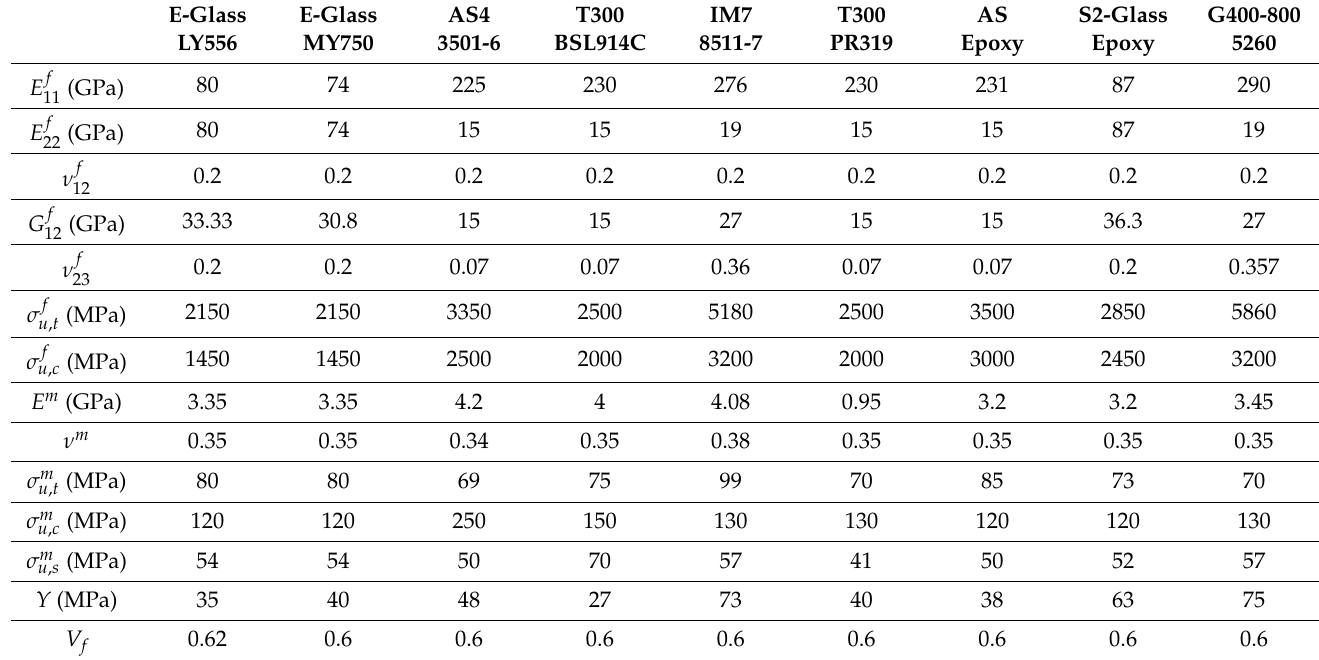
Table 2. Constituent properties and other parameters of the nine composite systems used in WWFEs